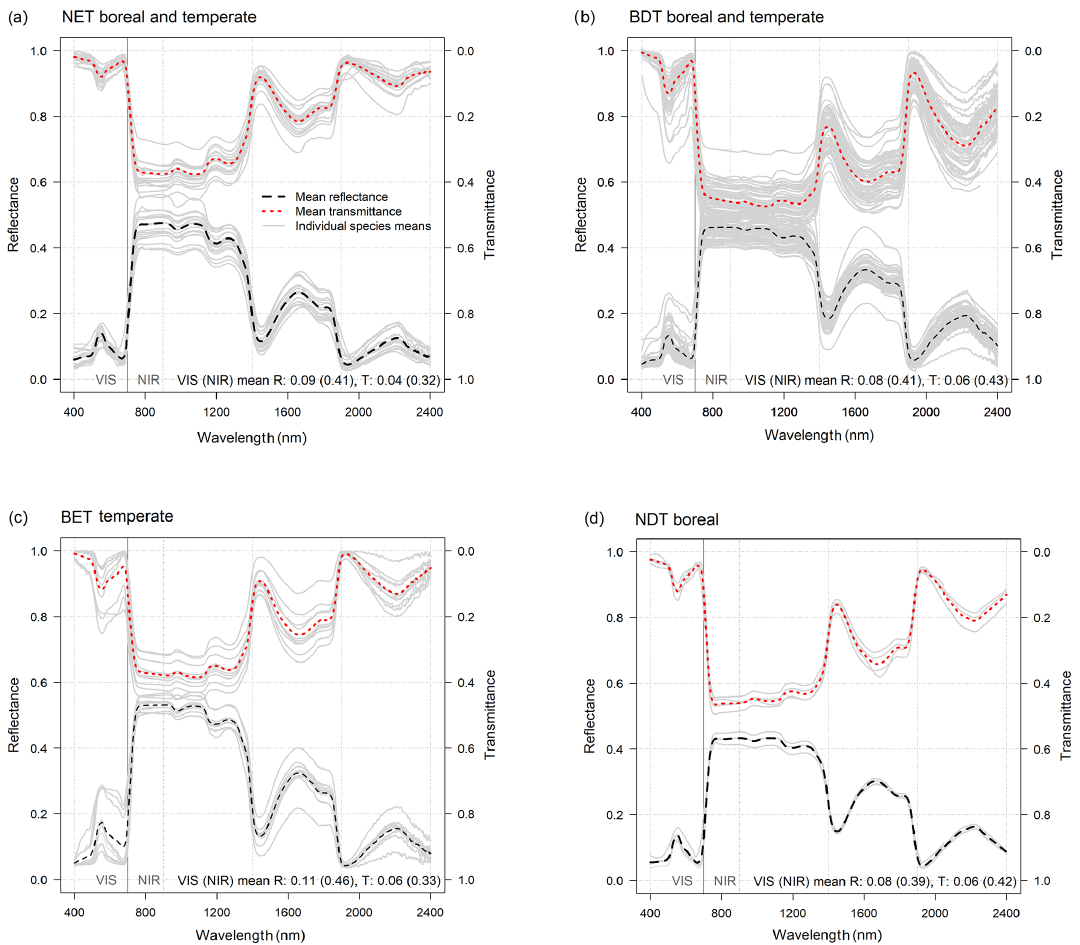
Figure 3. Average reflectance ( R (λ) ) and transmittance ( T (λ) ) spectra of foliage for forest plant functional types (PFTs) for n species samples: (a) NET boreal and temperate ( n = 18), (b) BDT boreal and temperate ( n = 54), (c) BET temperate ( n = 10), and (d) NDT boreal ( n = 4). Individual-species-mean R (λ) and T (λ) spectra are shown using light gray lines and are used to represent the within-PFT deviation in mean spectra (see individual species estimates in S2). The mean R (λ) and T (λ) for VIS (400–700nm) and NIR (701–2400nm) wavelengths are provided at the bottom of the images and are calculated as an average of the species means. Note that all VIS and NIR averages of R (λ) and T (λ) were weighted with solar irradiance spectra (SI (λ) )